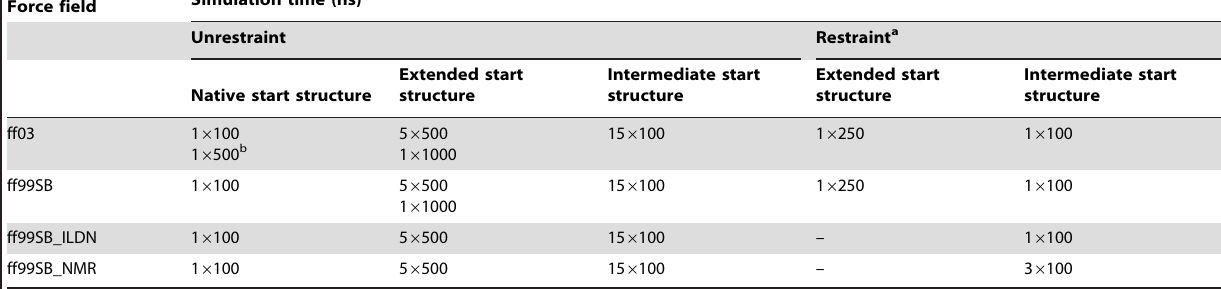
Table 1. Simulation